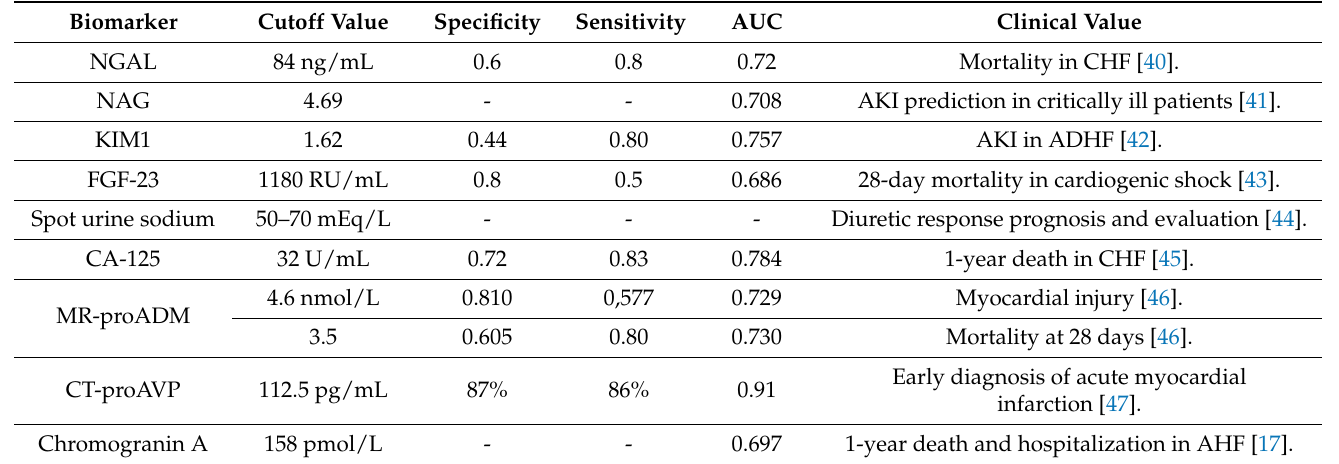
Table 3. Predictive characteristics of selected biomarkers in heart